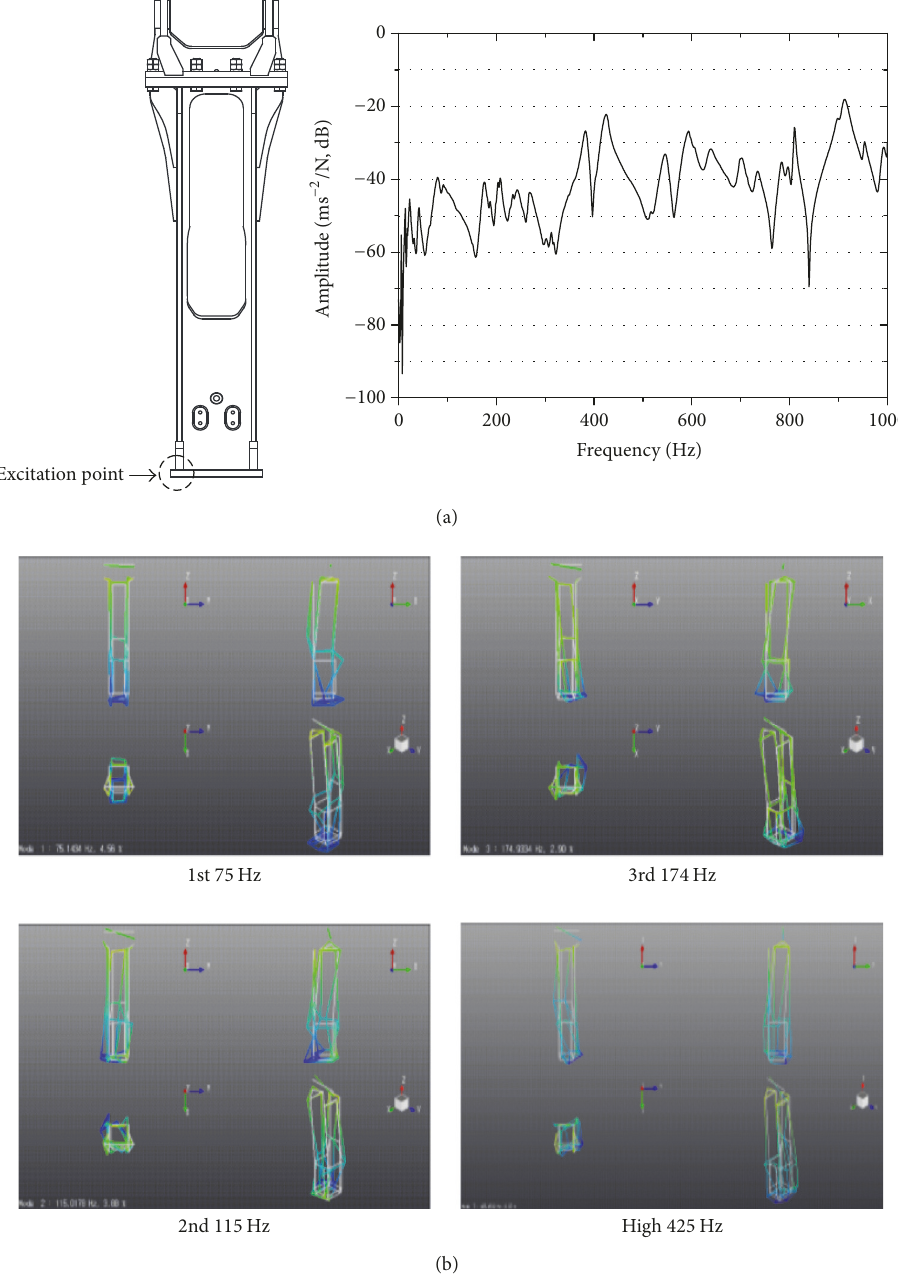
Figure 8: Modal impact experiments: (a) measured frequency response function, (b) mode shapes of the hydraulic